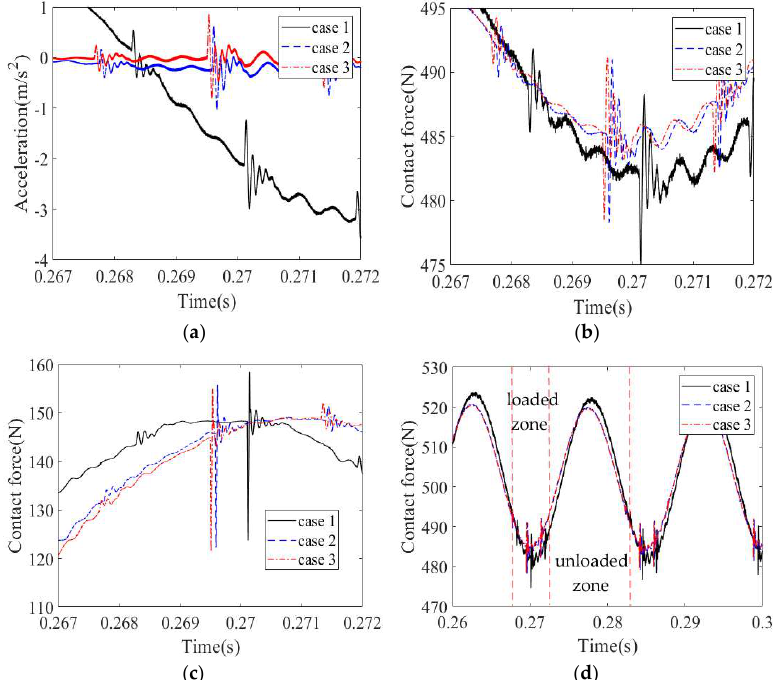
Figure 10. The acceleration signal and forces in the bearing under inner ring defect and housing stiffness: ( a ) housing acceleration signal from 0.267 s to 0.272 s; ( b ) contact force between outer ring and housing from 0.267 s to 0.272 s; ( c ) contact force between the roller and outer ring from 0.267 s to 0.272 s; ( d ) contact force between outer ring and housing from 0.26 s to 0.3 s.